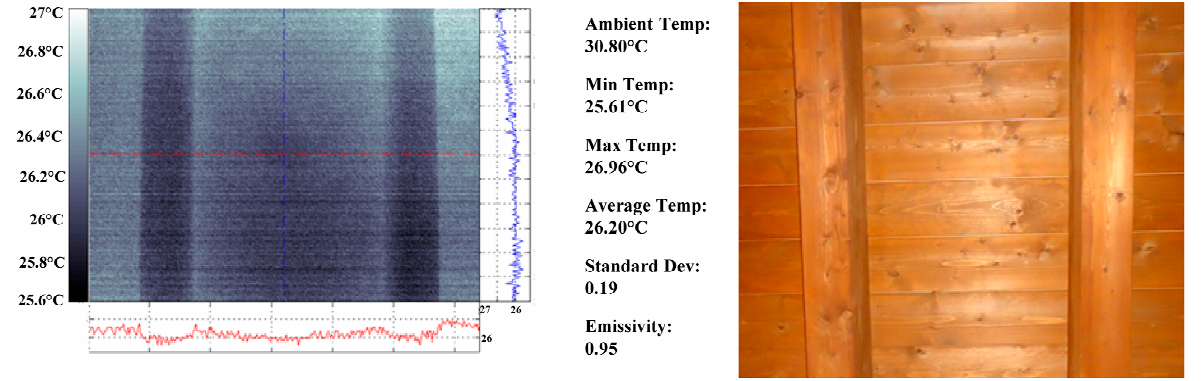
Figure 5. Thermogram ( left ) and photograph ( right ) of the selected investigation area for the roof timber structure.